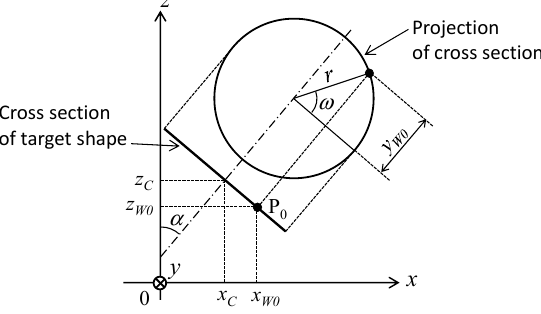
Figure 1. xyz coordinates of point P 0 on a circular cross section of the target shape. The y axis is in the direction into the page.